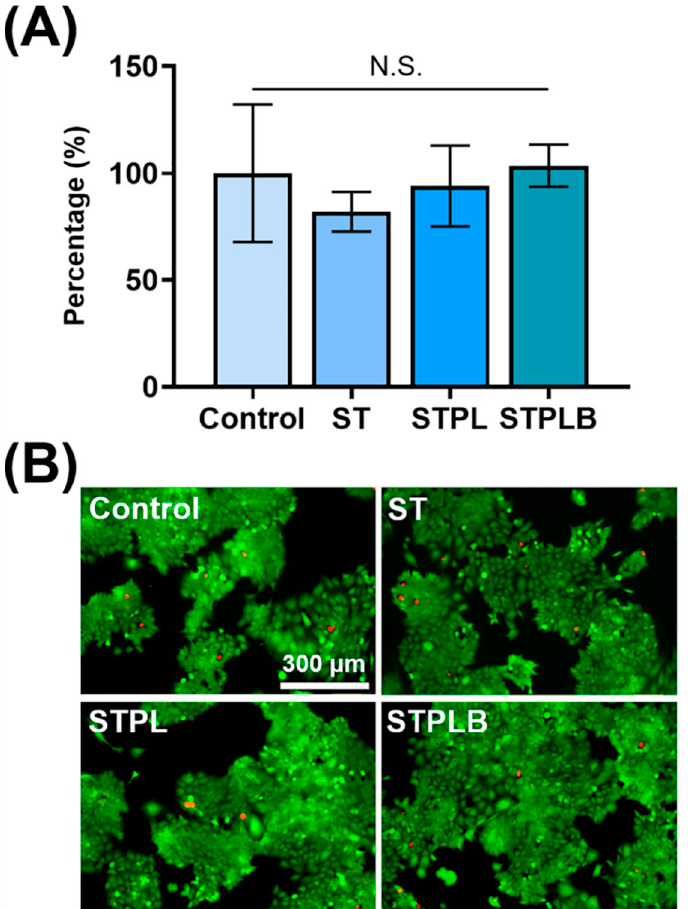
Figure 7. Evaluation of cytotoxicity in vitro at day 3. Rat osteoblastic cell line UMR106 cells treated with gelatin sponges prepared using three different molds: ST: silicon tube; STPL: ST covered with PVDC at the lateral side; STPLB: ST covered with PVDC at the lateral and bottom sides. Control: no sponges. ( A ) WST-8 assay. Mean with SD ( n = 4, p > 0.05, one-way ANOVA with Tukey–Kramer tests). N.S.: no statistical difference. ( B ) Live or dead viability staining. Green: live cells; red: dead cells.